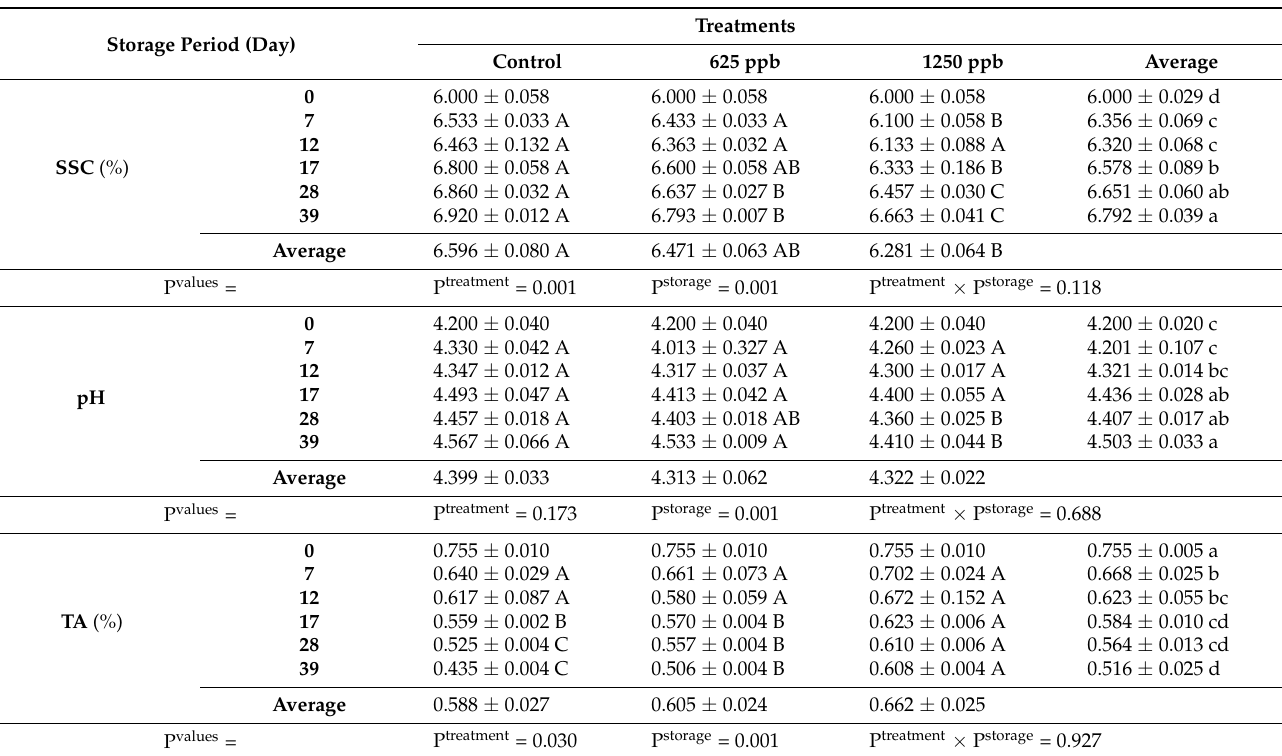
Table 2. The SSC, pH, and TA during storage of ‘Seyit F1’ cocktail tomato ( Solanum lycopersicum L.). Data are presented as means ± SEM.